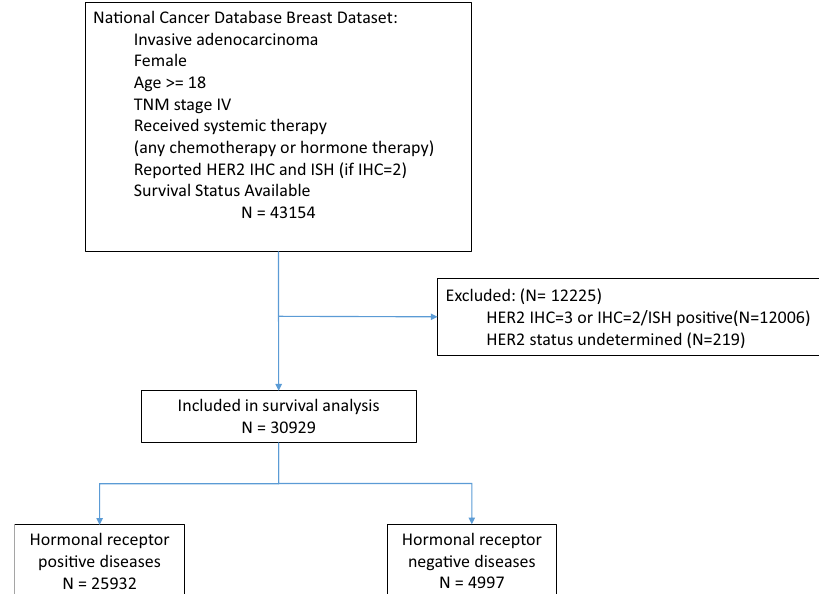
Fig. 5 Study design. NCDB National Cancer